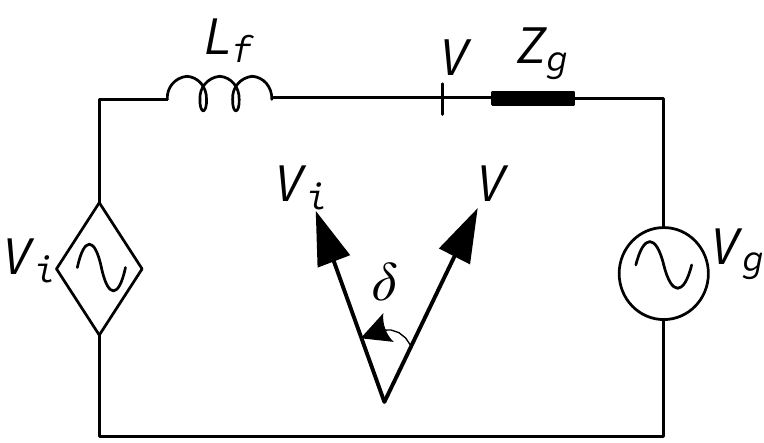
Figure 7. Modelling converter of the 2L-VSC as a voltage source.